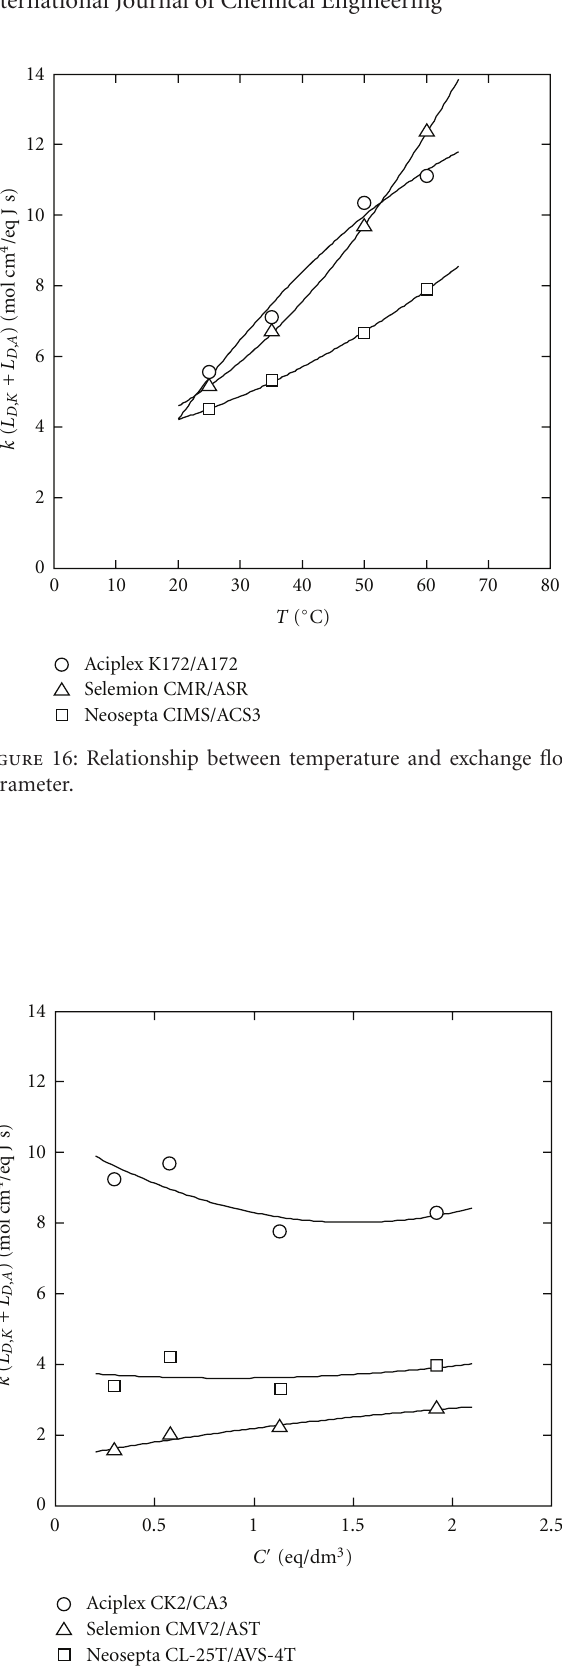
Figure 17: Relationship between salt concentration in a feeding solution and exchange flow